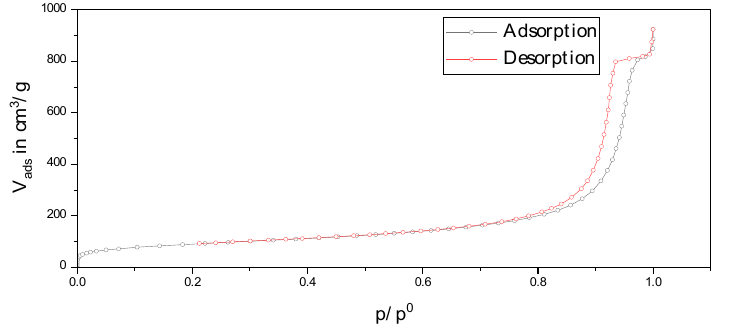
Figure 2. Nitrogen physisorption isotherm of the carrier material Aerosil380. B.E.T. = 330 m 2 /g (p/p 0 = 0.001 to 0.23), B.J.H. = 300 m 2 /g (p/p 0 = 0.3 to 0.95). According to IUPAC, the hysteresis can be classified as type IV(a), indicating a mesoporous material with multilayer adsorption [44]. This property can be attributed to the agglomeration of the spheri- cal silica particles, as confirmed by the scanning electron microscope (SEM) images in Figure 3, and not to an ordered pore structure as known for other mesoporous silicates, e.g., SBA-15 [45]. The